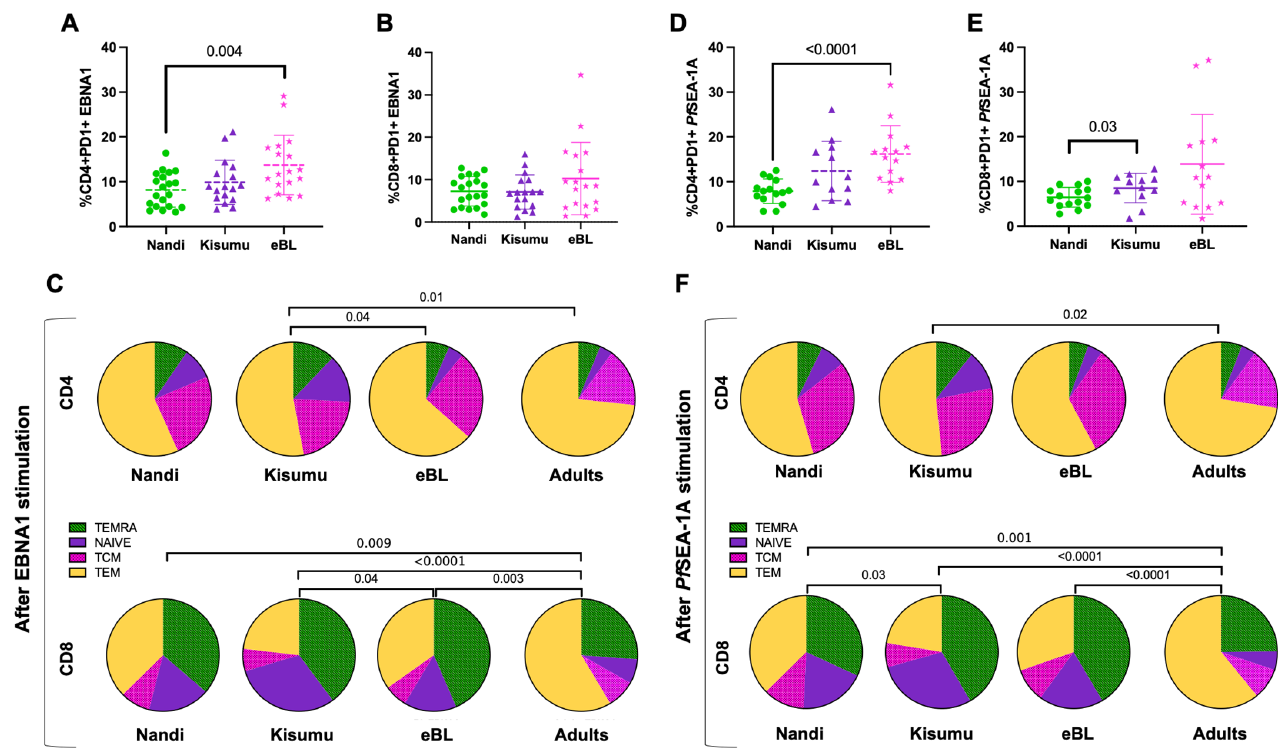
Figure 7. Comparison of PD-1 expressing CD4 + and CD8 + T cell frequencies across study groups. Comparison of PD-1 expressing ( A ) CD4 + and ( B ) CD8 + T cells after EBNA1 stimulation between groups of children (Nandi green circles; Kisumu purple triangles and eBL pink stars) using Mann–Whitney test. ( C ) The mean proportion (pie slice) of PD-1-expressing CD4 + and CD8 + after EBNA1 stimulation was compared across study groups using χ 2 test. Comparison of PD-1 expressing ( D ) CD4 + and ( E ) CD8 + T cells after Pf SEA-1A stimulation between groups of children (Nandi green circles; Kisumu purple triangles and eBL pink starts) using Mann–Whitney test. ( F ) The mean proportion (pie slice) of PD-1-expressing CD4 + and CD8 + after Pf SEA-1A stimulation was compared across study groups using χ 2 test. T cell subsets were defined by CD45RA and CCR7 expressions: T EMRA (green, CD45RA + CCR7 − ), T NAIVE-LIKE (purple, CD45RA + CCR7 + ), T CM (pink, CD45RA − CCR7 + ) and T EM (yellow, CD45RA − CCR7 − ).